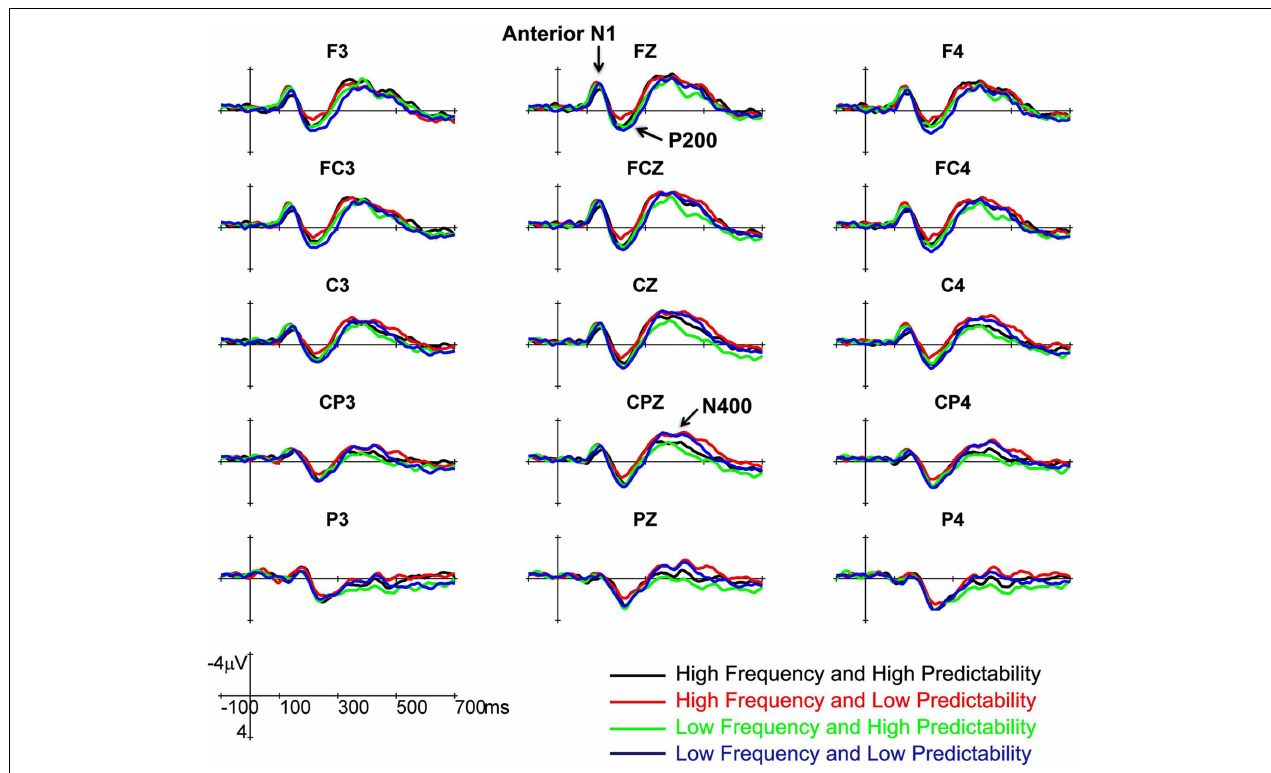
FIGURE 1 |The grand averaged ERPs to the high- and low frequency target words in high- and low predictability contexts across two sessions from 15 representative electrodes. Major ERPs components for further analysis are labeled.